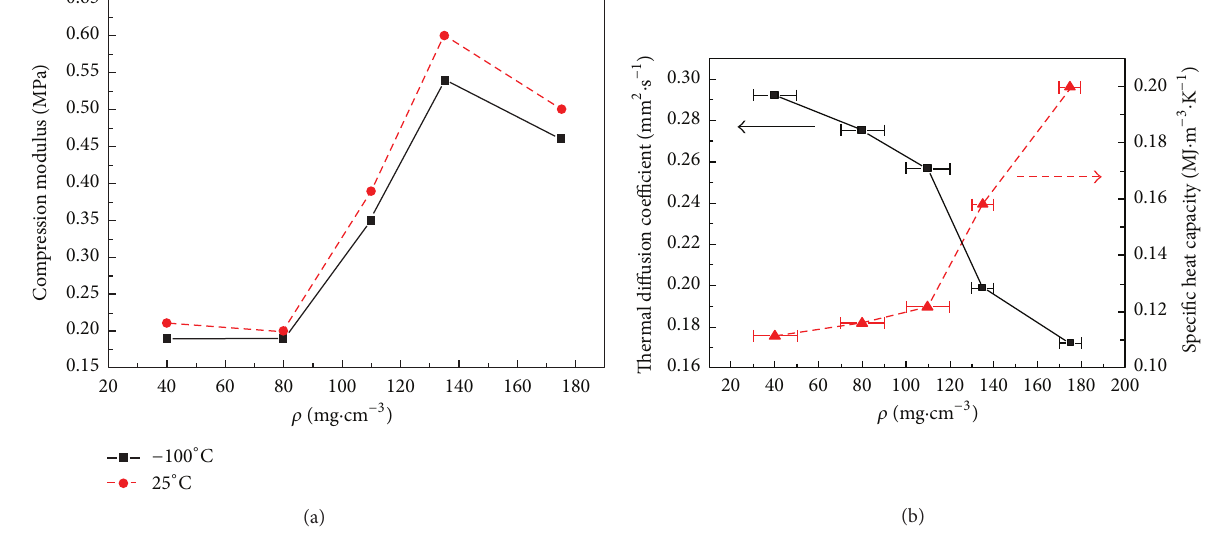
Figure 3: Compression modulus of aerogels with different densities at − 100 ∘ C and 25 ∘ C [103]. Relationship between thermal diffusion coefficient and specific heat capacity with density of aerogels